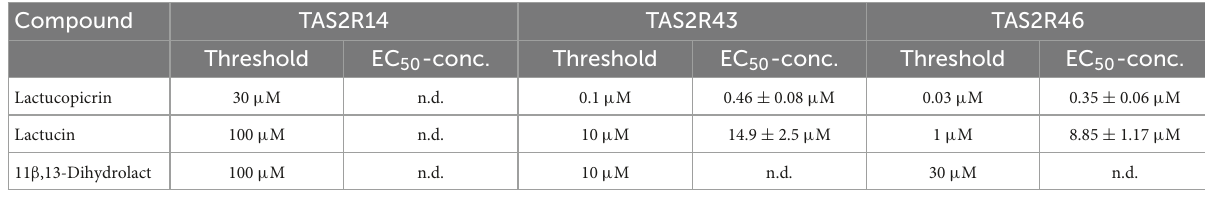
TABLE 1 Threshold- and EC 50 -concentrations of test